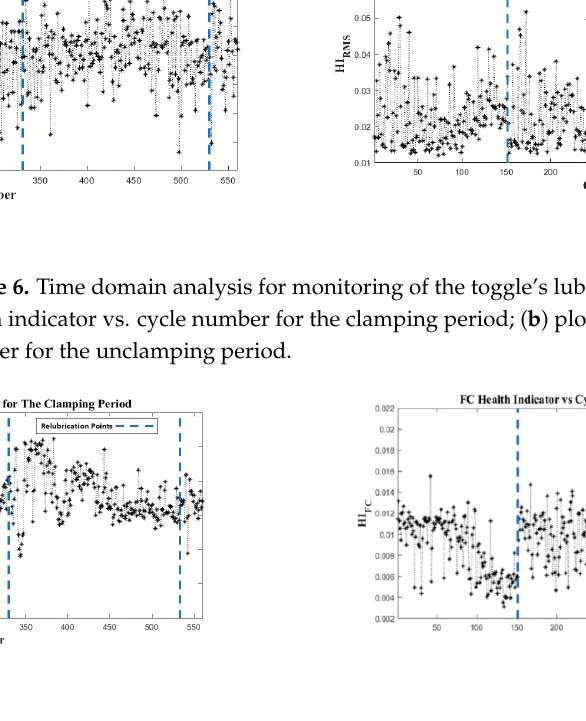
Figure 7. Frequency domain analysis for condition monitoring of the toggle’s lubricating condition: ( a ) plot of FC health indicator vs. cycle number for the clamping period; ( b ) plot of FC health indicator vs. cycle number for the unclamping period.